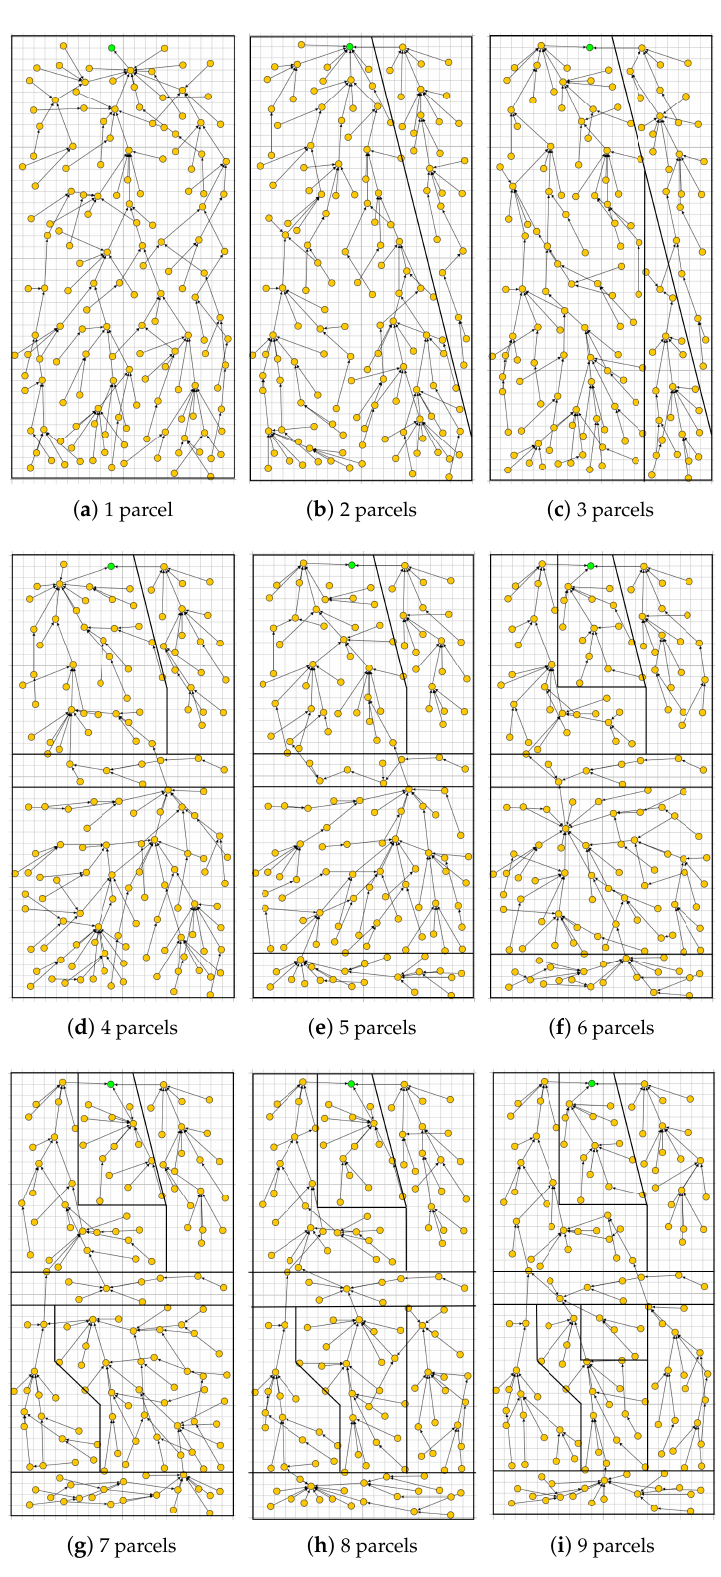
Figure 8. The DODAG built by